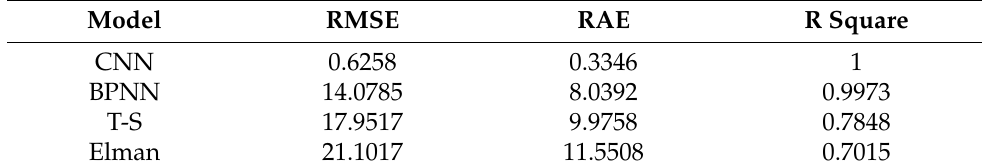
Table 2. RMSE, RAE and R 2 comparison of four neural networks.